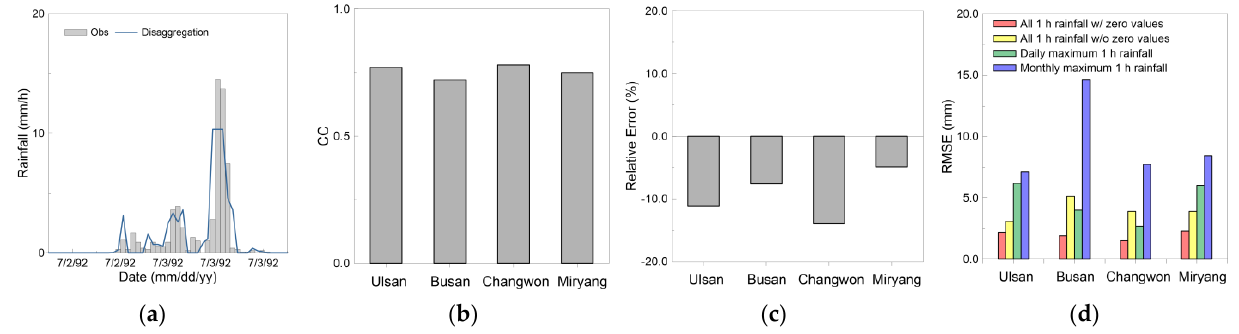
Figure 6. Verification results of the disaggregation method against 1 h rainfall observed data. ( a ) Comparison of time series data, ( b ) correlation coefficient, ( c ) relative error (%) of daily maximum 1 h rainfall, representing underestimation with a negative value and overestimation with a positive value, and ( d ) RMSE (mm). In the RMSE result, ‘All’ indicates the results for the entire application period (including with or without zero values), and ‘Daily’ shows the results for the daily maximum 1 h rainfall.